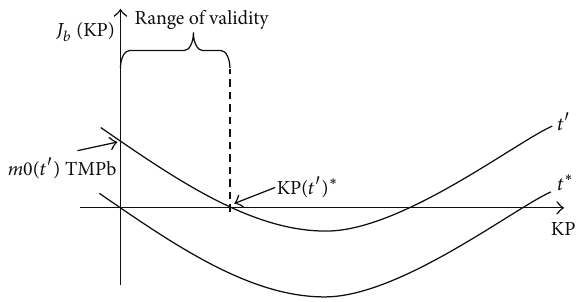
Figure 1: Plot of (13) at fixed time points 𝑡 󸀠 and 𝑡 ∗ .